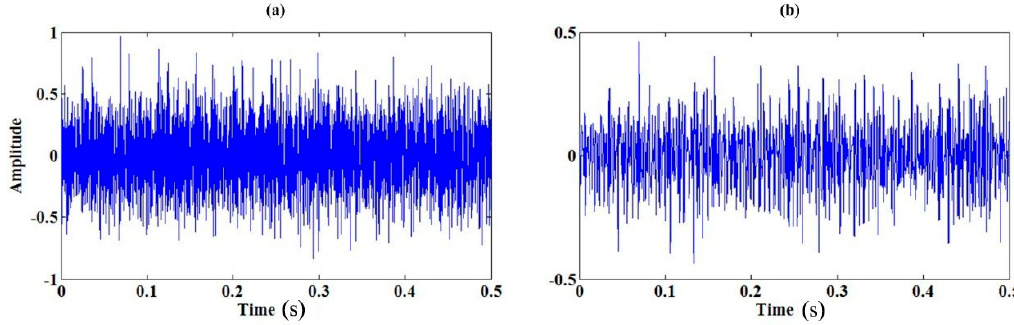
Figure 11. ( a ) The orginal sound signal; and ( b ) the denoised sound signal.